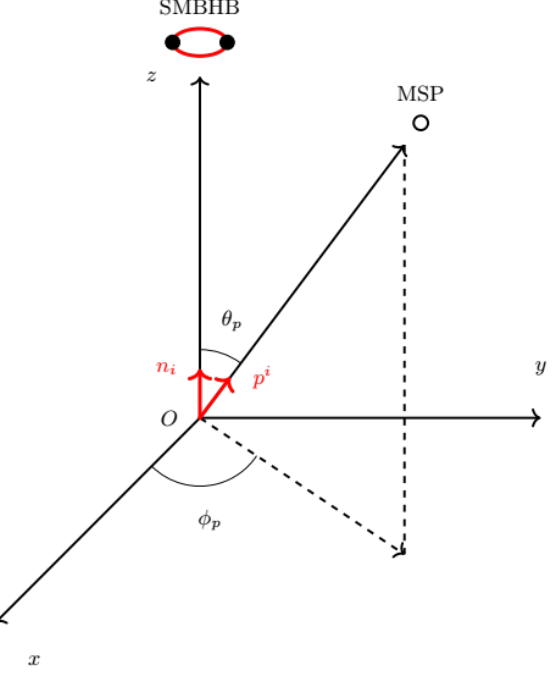
Figure 1. Scheme of the adopted Oxyz coordinate system, chosen so that the versor n i is aligned with the z -axis. The black circle pair indicates the SMBHB, pointed by the versor n i , while the white circle indicates the MSP, pointed by the versor p i . In the figure, the distances of the SMBHB and the MSP from the origin O , where the observer is placed, are not in